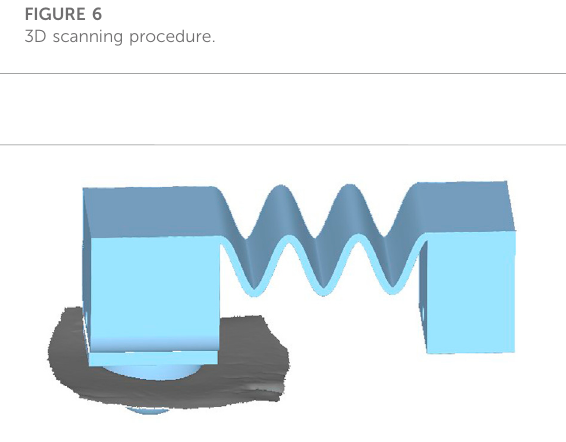
FIGURE 7 Reconstruction of the fi ngertip